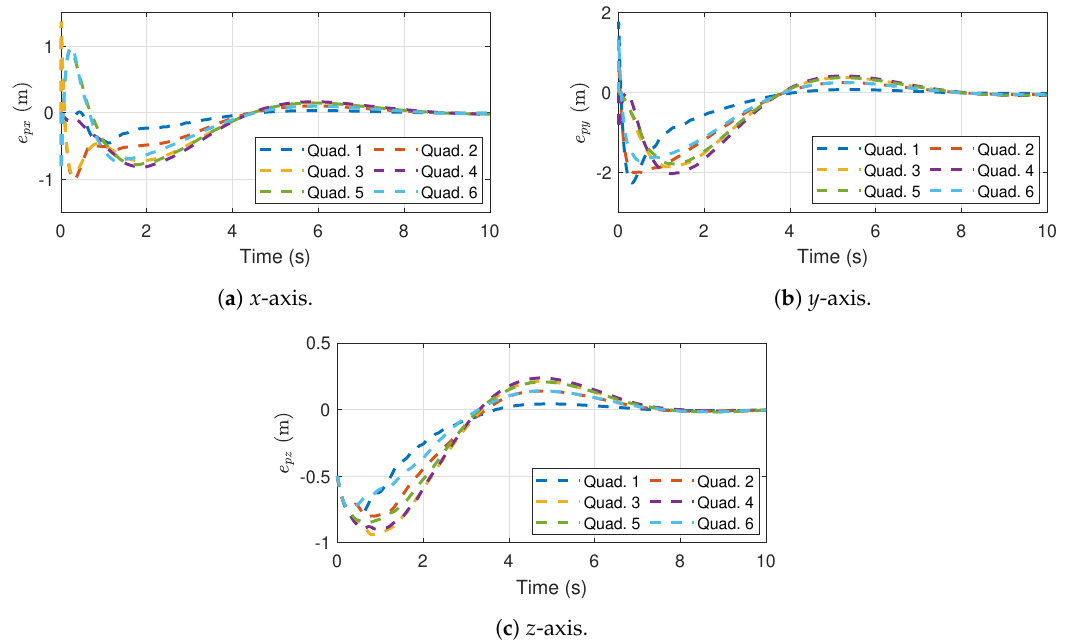
Figure 4. Formation flight tracking error of the six quadcopters along the x -, y -, and z -axis.